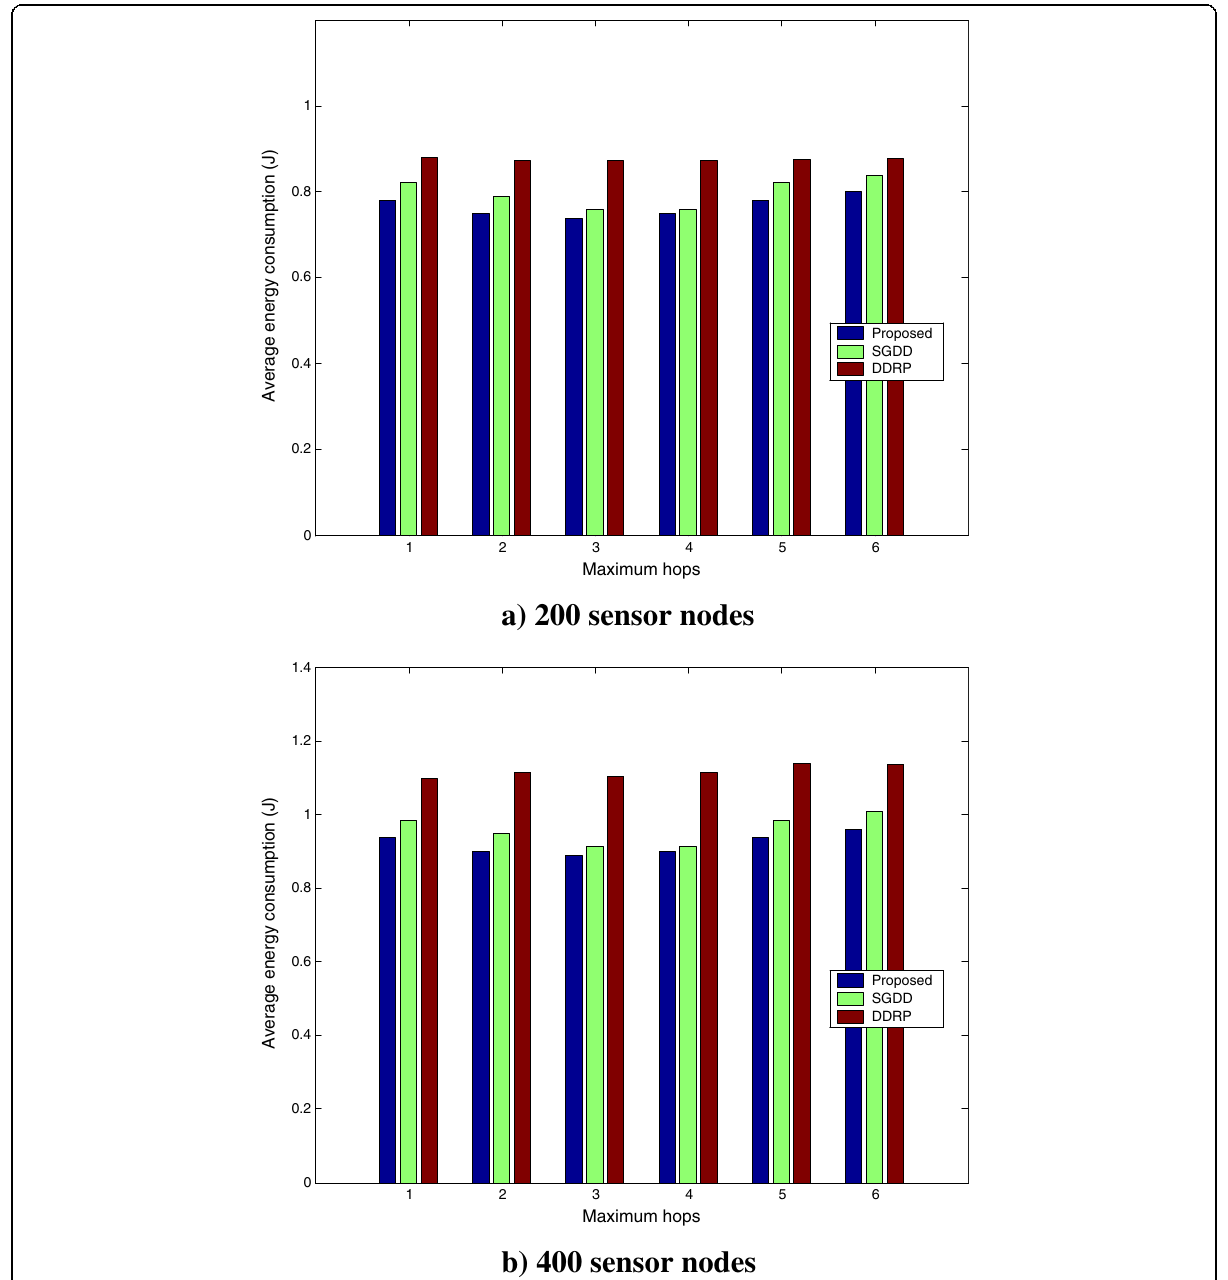
Fig. 2 The average energy consumption under different hop